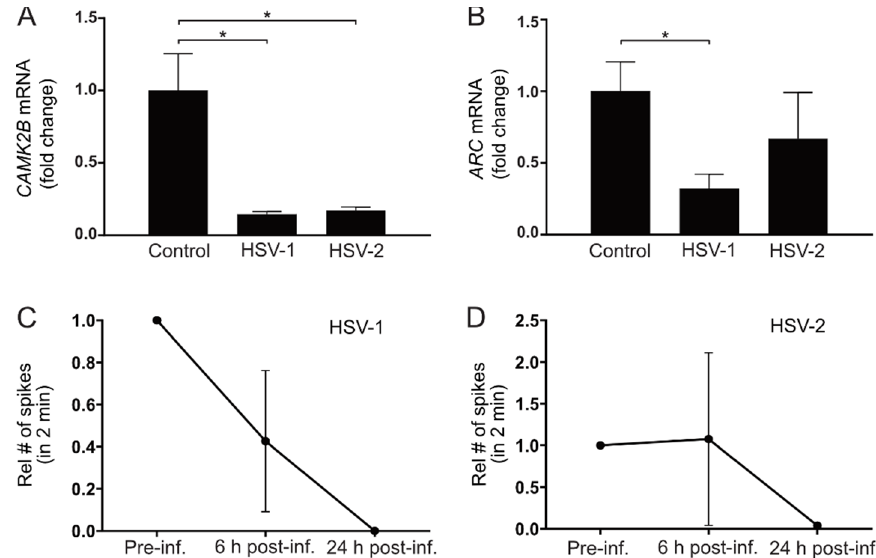
Figure 7. HSV infection of neurons reduces synaptic activity and gene expression related to synaptic activity and plasticity. ( A , B ) CAMK2B and ARC gene expression measured with qPCR in neurons 48 h after infection with HSV-1 or HSV-2 at MOI = 0.1. ( A ) Viral infection of neurons with HSV-1 and HSV-2 significantly decreased the expression of the synaptic plasticity marker CAMK2B. ( B ) Viral infection of neurons with HSV-1 significantly decrease expression of ARC compared with non-infected control neurons. HSV-2 infection shows a tendency to decrease ARC gene expression compared with control, although not reaching statistical significance. Target gene expression was related to reference gene 18S, which remains stable after infection, and correlated to average control. Bars represent mean fold change of three separate differentiations from two iPSC lines +/ − SEM. * p < 0.05 from Student’s t-test. ( C , D ) Synaptic activity measured with multielectrode array in neurons 6 and 24 h after infection with HSV-1 or HSV-2 at MOI = 1. ( C ) HSV-1 decreased synaptic activity in neurons 6 and 24 h post-infection. ( D ) HSV-2 decreased synaptic activity in neurons twenty-four hours post-infection. Data represent the mean number of spikes in 2 min for two separate differentiations from one iPSC line +/ − range relative to the respective well pre-infection (set to 1).